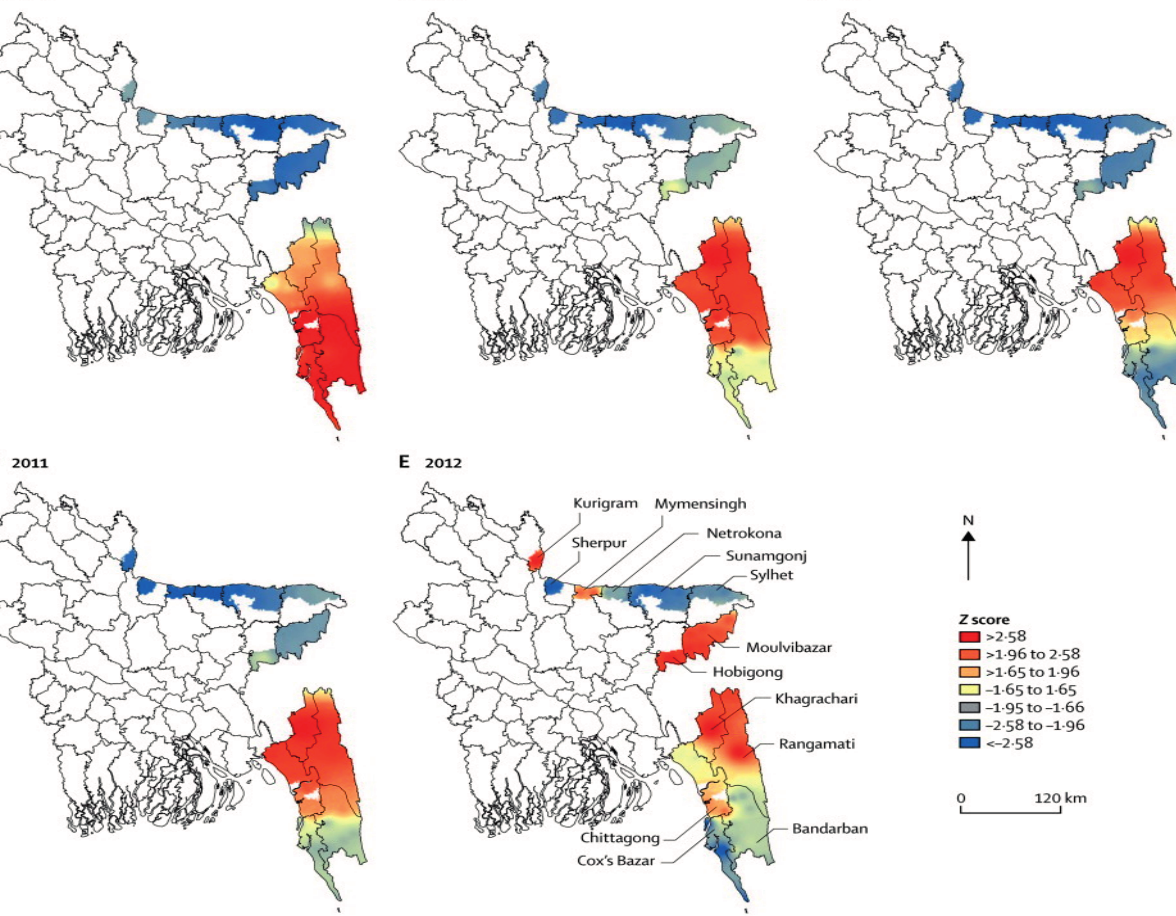
Figure 1. Malaria prevalence in Bangladesh in 2008, and progress in malaria control from 2009 to 2012 *. * For 2009–2012, red areas show the regions with the largest decreases in malaria prevalence. (Z-score: A statistically positive Z-score indicates high rates and a negative Z-score indicates of low